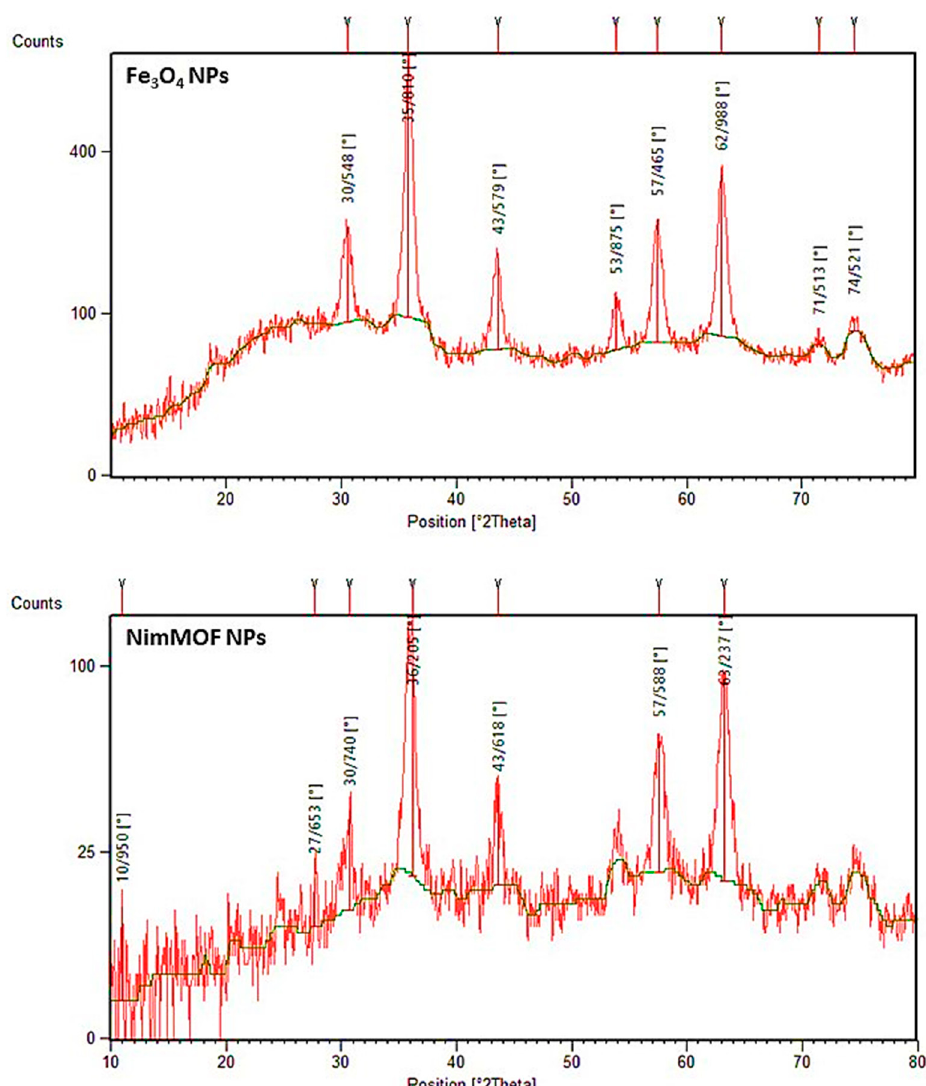
Figure 3. XRD pattern of the magnetic Fe 3 O 4 and the NimMOF